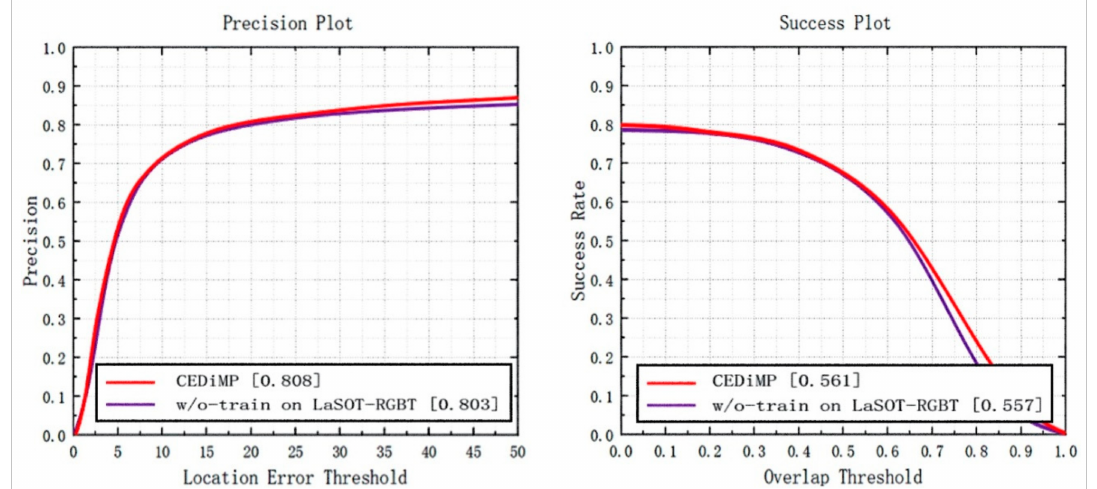
Figure 15. Comparison results w/o-training on LaSOT-RGBT.